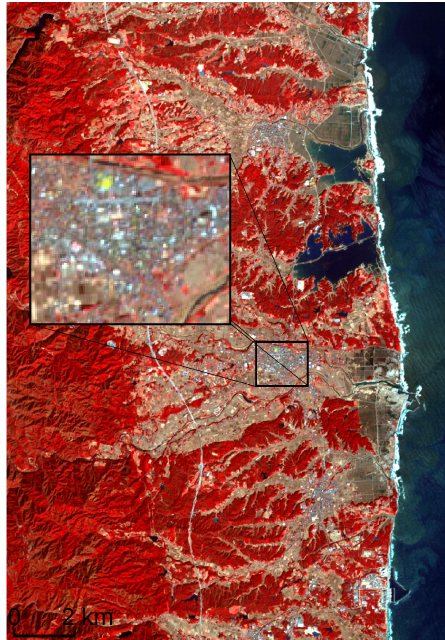
Figure 3. ASTER Image with false colors of the Fukushima Prefecture taken on 19 March 2011. The zoom on this image shows that the resolution might not be high enough to individually detect the status of small